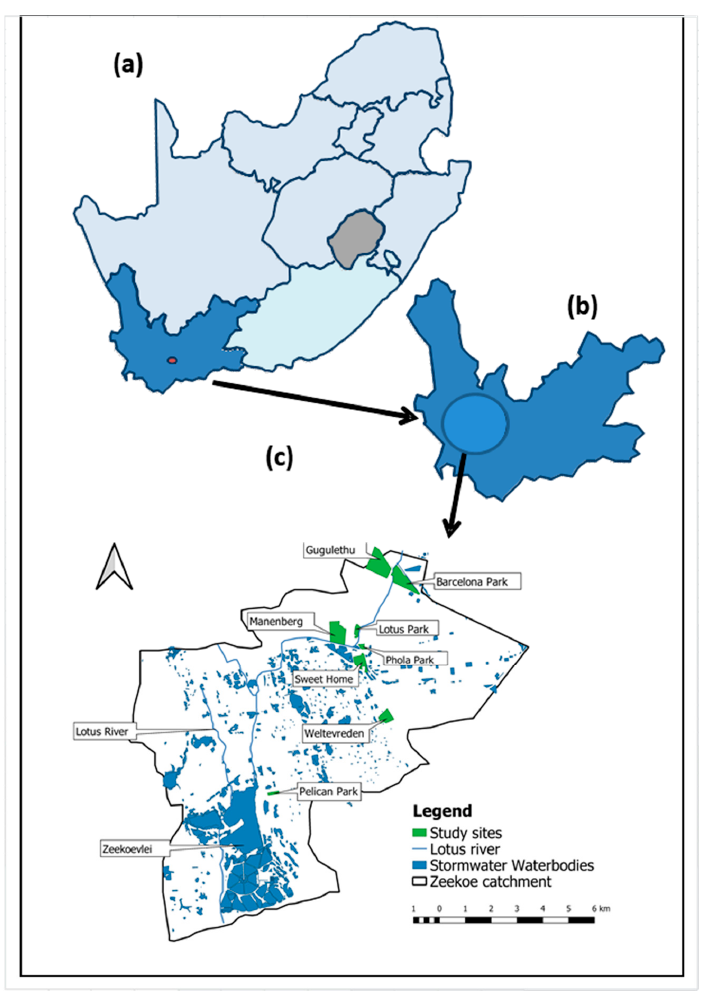
Figure 1. Map of South Africa ( a ), Western Cape ( b ), and the catchment area in Cape Town showing the six informal settlements in the (Zeekoe catchment) and different land use ( c